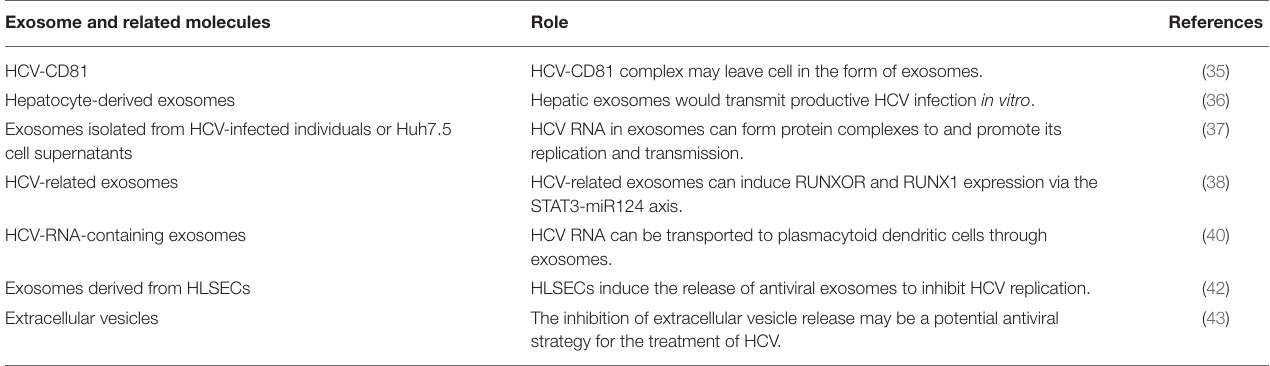
TABLE 2 | The role of exosomes in hepatitis